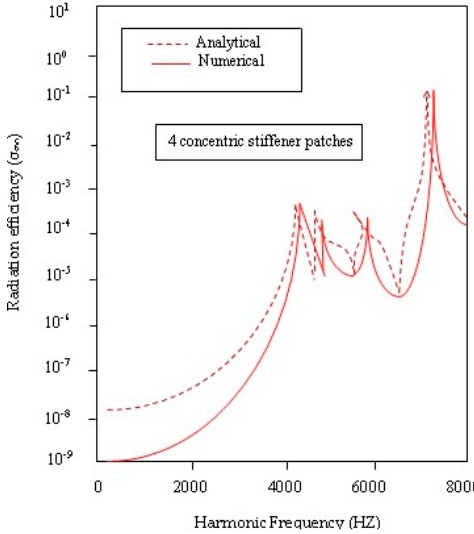
Figure 23. Comparison of radiation efficiency ( σ mn ) analytically and numerically for annular plate attached with 4 concentric stiffener patches and having parabolic decreasing thickness variations (Case I) for taper ratio T x = 0.75.